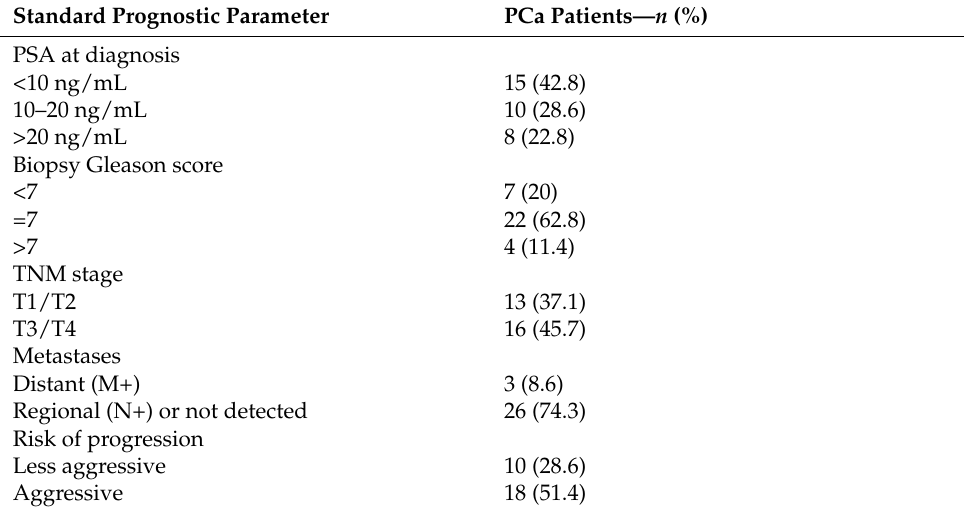
Table 1. Classification of PCa patients based on the values of standard prognostic parameters and on the risk of disease